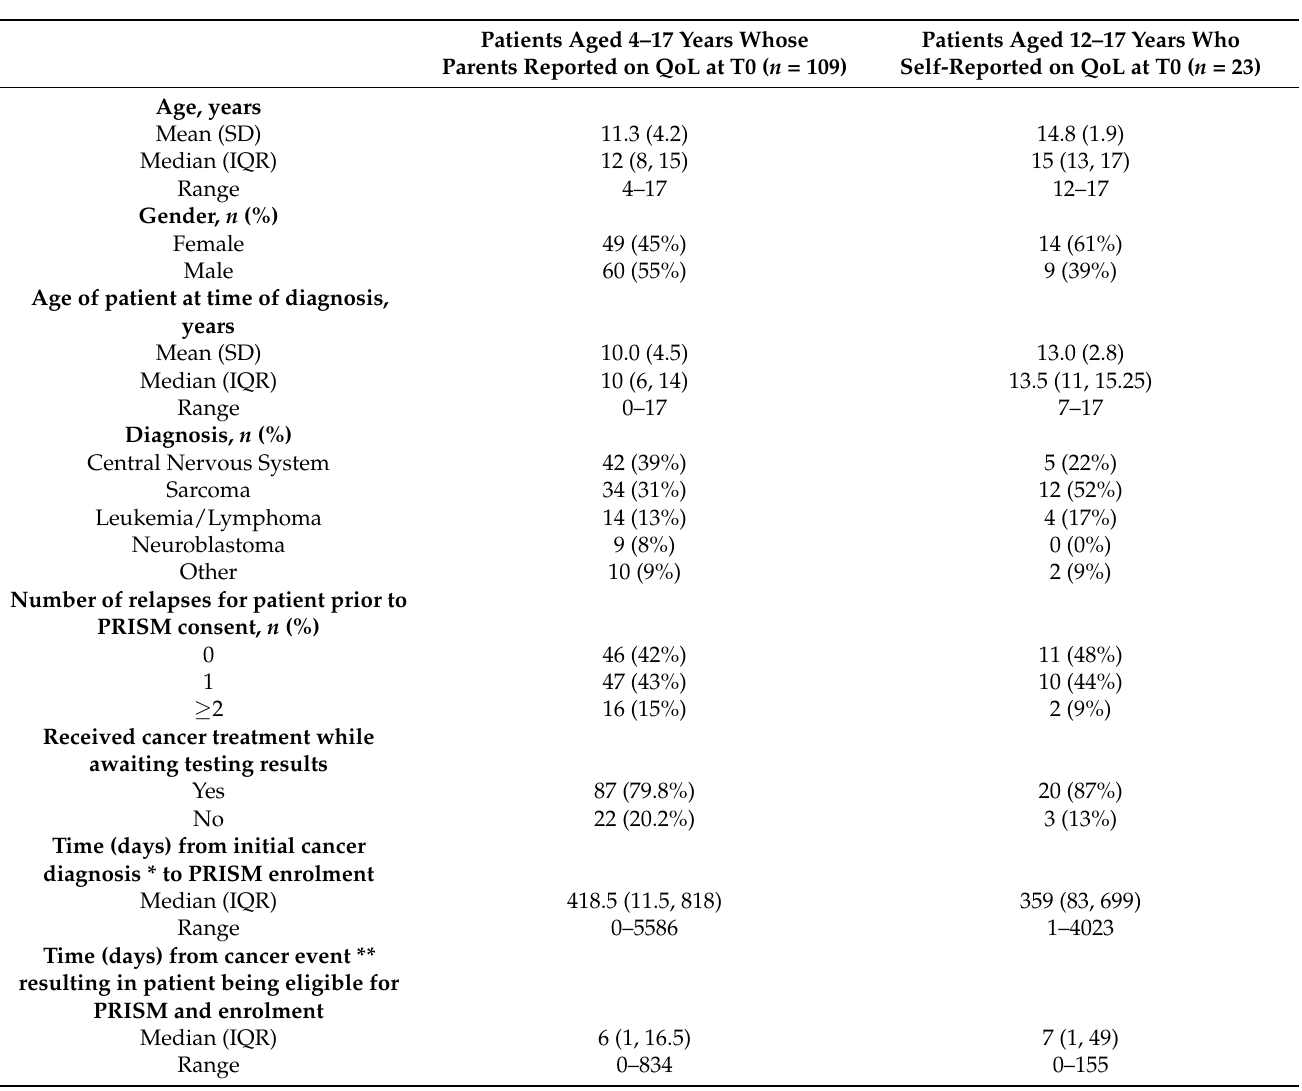
Table 2. Demographics of patients for whom we have data on QoL at